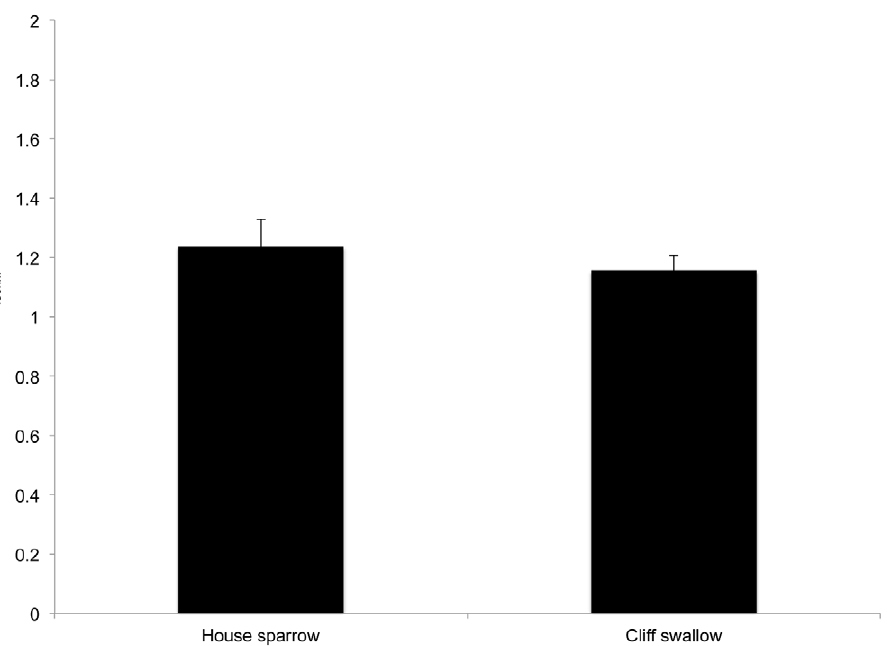
Figure 1. Total IgY ELISA Results. Values shown represent mean ( + SEM) optical density values (O.D. 450nm ) for total IgY in cliff swallows and house sparrows. NS= non-significant difference ( P .